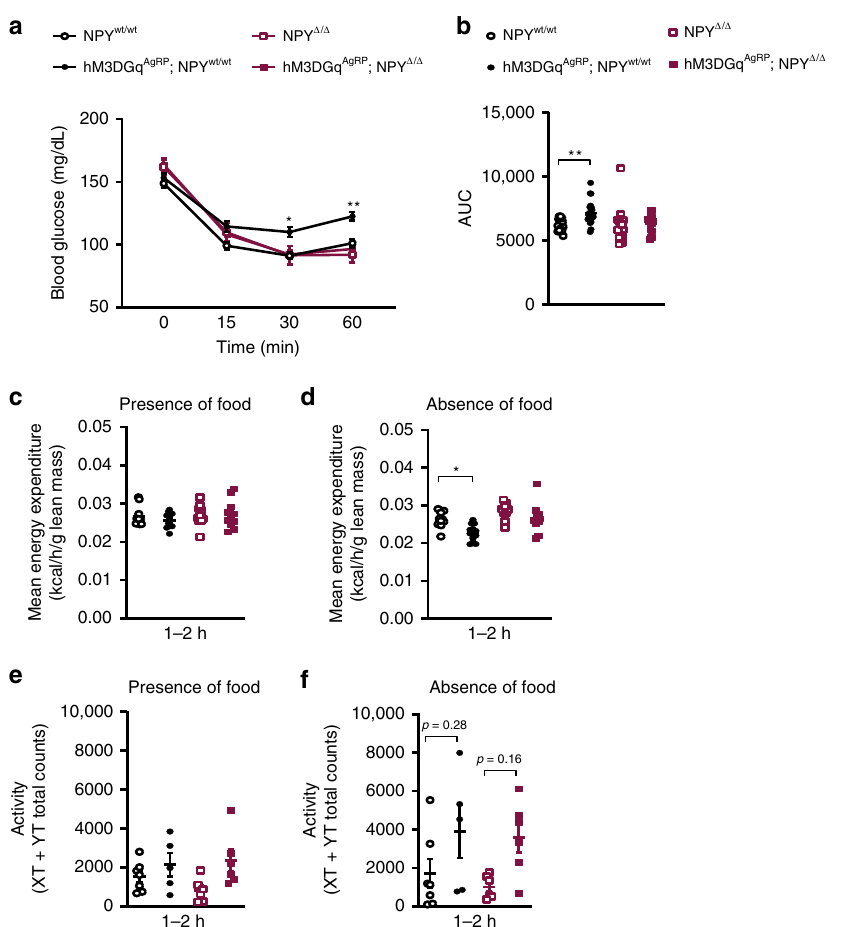
Fig. 7 NPY is necessary for the acute insulin resistance upon chemogenetic activation of AgRP neurons. a , b Insulin tolerance test in NPY-expressing and NPY-de fi cient mice and corresponding area under the curve (AUC); n = 17 mice for NPY wt/wt , n = 23 mice for hM3DGq AgRP ; NPY wt/wt , n = 14 mice for NPY Δ / Δ and n = 15 mice for hM3DGq AgRP ; NPY Δ / Δ ). c Energy expenditure in the presence of food (1 – 2 h post injection) is similar in all groups of mice ( n = 10 mice for NPY wt/wt , hM3DGq AgRP ; NPY wt/wt and NPY Δ / Δ , and n = 11 mice for hM3DGq AgRP ; NPY Δ / Δ ). d Energy expenditure in the absence of food (1 – 2 h post injection) is dependent on NPY expression ( n = 10 mice for NPY wt/wt , n = 12 mice for hM3DGq AgRP ; NPY wt/wt , n = 9 mice for NPY Δ / Δ and n = 10 mice for hM3DGq AgRP ; NPY Δ / Δ ). e Locomotor activity in the presence of food (1 – 2 h post injection) is similar in all groups of mice ( n = 7 for NPY wt/wt , n = 5 for hM3DGq AgRP ; NPY wt/wt and n = 6 for NPY Δ / Δ and hM3DGq AgRP ; NPY Δ / Δ ). f Locomotor activity in the absence of food (1 – 2 h post injection) is largely independent of NPY ( n = 7 for NPY wt/wt , n = 5 for hM3DGq AgRP ; NPY wt/wt and n = 6 for NPY Δ / Δ and hM3DGq AgRP ; NPY Δ / Δ ). All animals were injected with CNO. Data are shown as mean ± s.e.m. Statistical analysis is represented by * p ≤ 0.05 and ** p ≤ 0.01 as determined by one-way ANOVA followed by Tukey post hoc test, except for panel a , where a two-way ANOVA followed by Tukey post hoc test was performed. Source data are provided as a Source Data fi